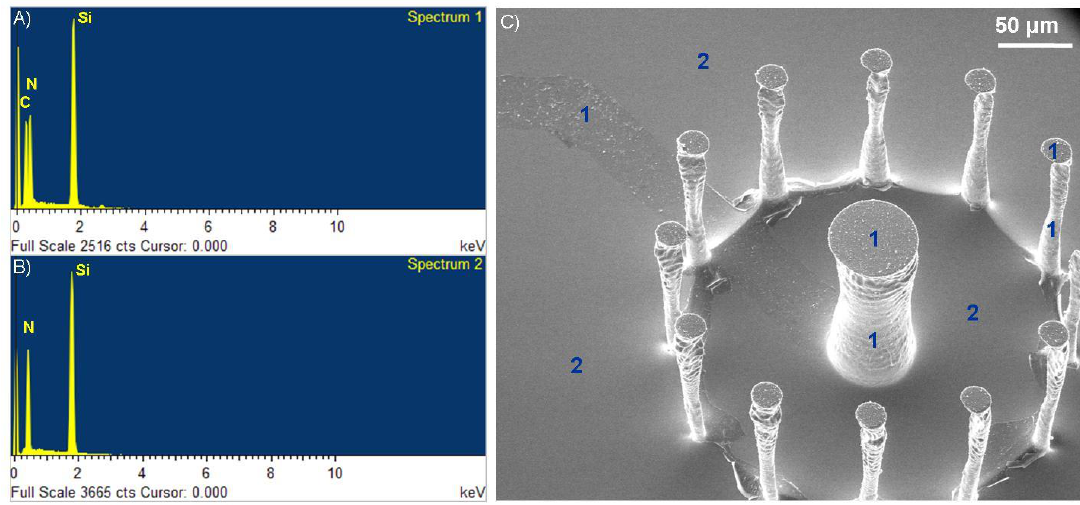
Figure 4. Validation of the presence of polymer films by EDX Analysis: ( A ) EDX spectrum of a polyaniline covered surface; ( B ) EDX spectrum of the silicon nitride surface without the PANI film; ( C ) SEM image of one of the 3D structures, tilted to a 30° angle, with corresponding areas: 1 (where the film was present, spectrum 1) and 2 (where the film was not present, spectrum